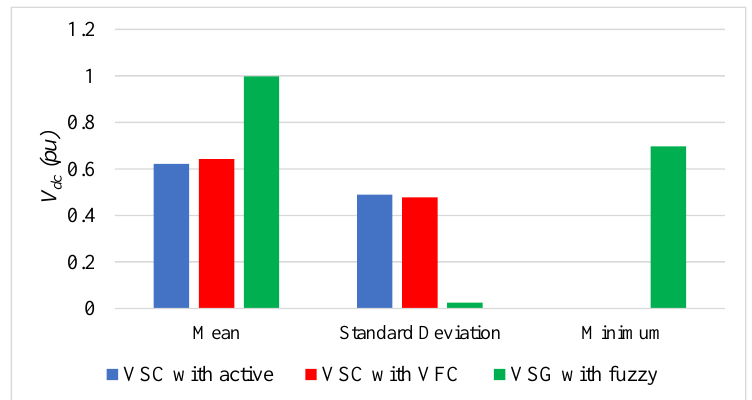
Figure 20. DC-link voltages of DER 1 for different scenarios.